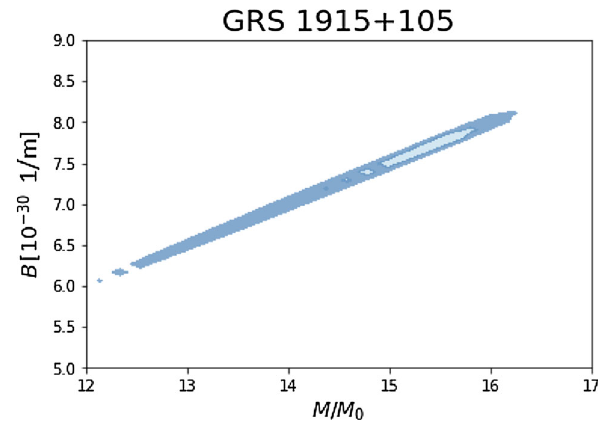
Fig. 8 Plot showing the magnetic field B and black hole mass between 68% and 95% CL